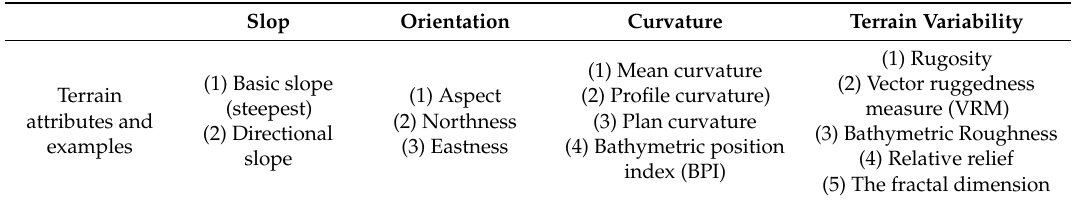
Table 4. Summary of the most commonly used terrain attributes derived from bathymetry and backscatter in marine-based studies. Modified after Dolan et al.